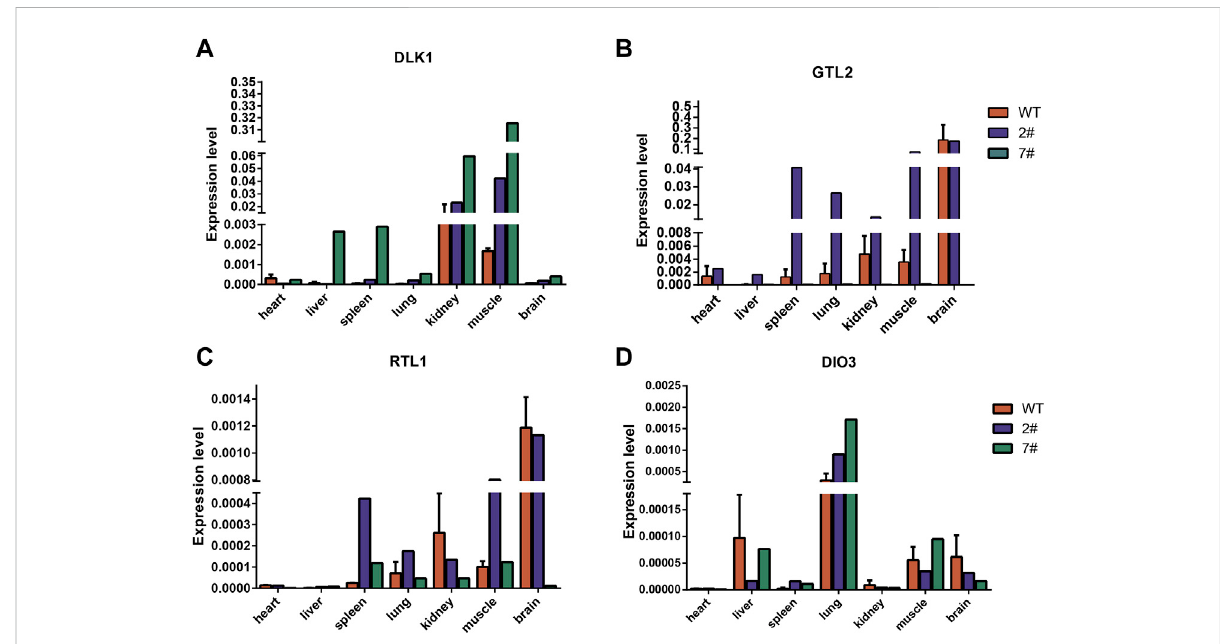
FIGURE 6 Analysis of DLK1-DIO3 imprinted domain gene expression in wild-type neonatal pigs and cloned neonatal pigs. (A) The expression of DLK1 in wild-typeneonatalpigsandclonedneonatalpigs. (B) Theexpressionof GTL2 inwild-typeneonatalpigsandclonedneonatalpigs. (C) Theexpression of RTL1 in wild-type neonatal pigs and cloned neonatal pigs. (D) The expression of DIO3 in wild-type neonatal pigs and cloned neonatal pigs. The quantitative results are presented for tissue samples at horizontal coordinates and gene expression levels at vertical